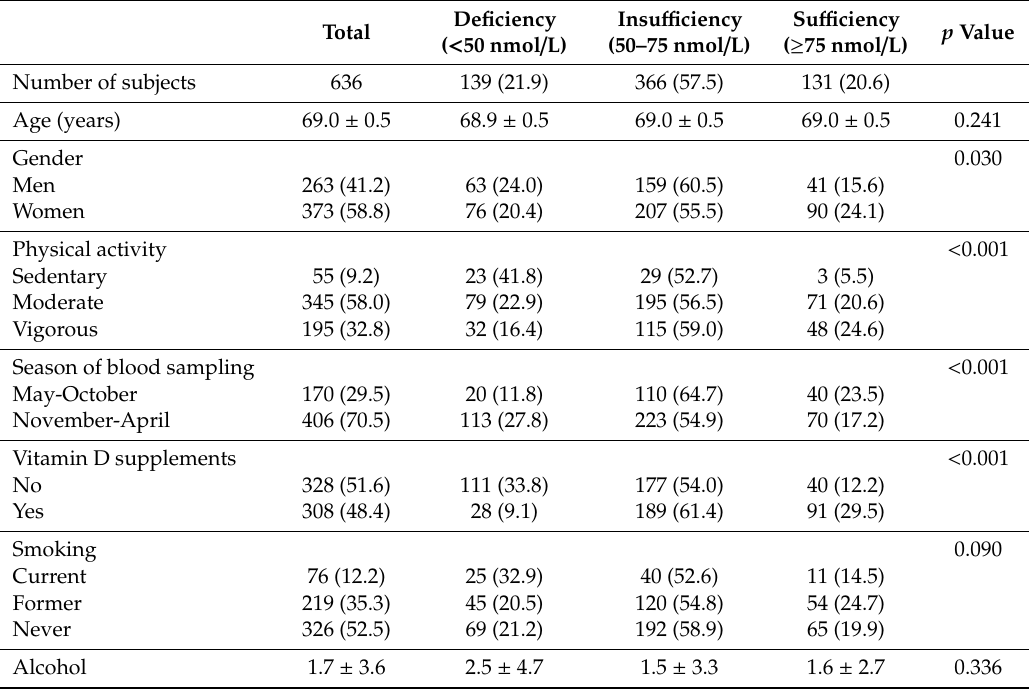
Table 1. Baseline characteristics of the subjects—25OHD levels.